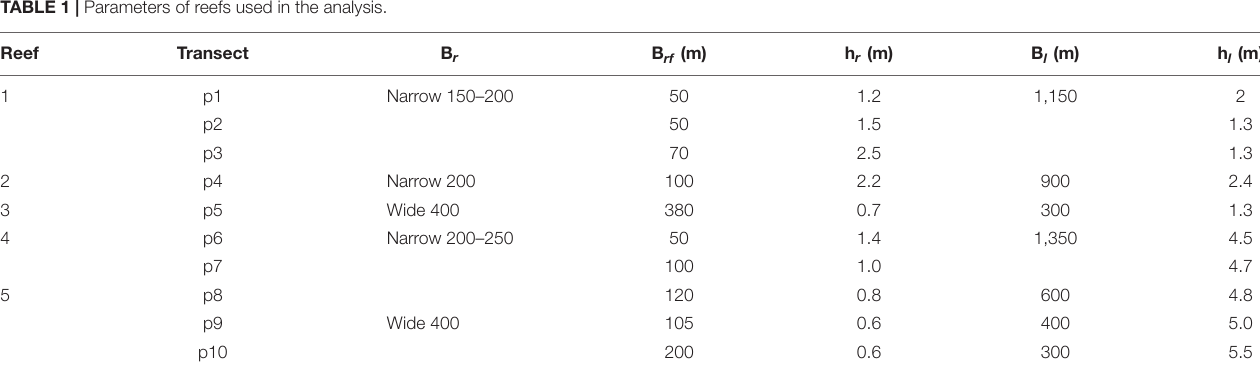
FIGURE 3 | Reef-beach transects. The black dot in each panel indicates the limit of the reef lagoon. The vertical axis provides the elevation in meters; the horizontal axis in the panels shows the horizontal distance from the shoreline in meters. TABLE 1 | Parameters of reefs used in the